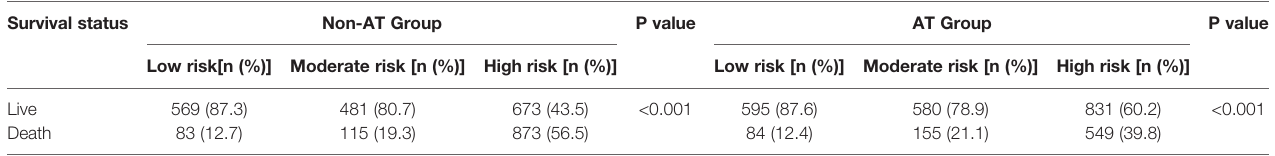
TABLE 4 | Risk strati fi cation in non-AT and AT group. Survival status